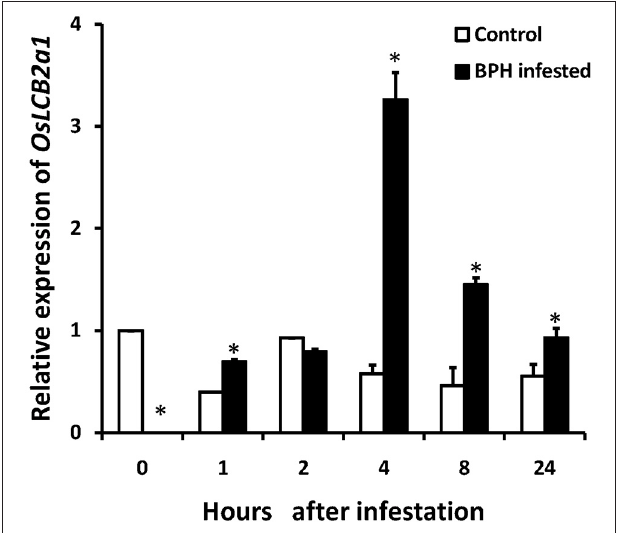
FIGURE 2 | Expression of OsLCB2a1 under BPH attack. Two weeks rice seedlings were infested with 3rd instar BPH nymph (20 nymphs/ seedling). Total RNA was isolated from rice seedlings infested by BPH at 0, 1, 2, 4, 8, 24 h and reversely transcribed into cDNA used as template in quantitative RT-PCR analysis. Values are mean ± SE ( n = 5). The asterisks indicate statistically significant differences between the treatments (One way ANOVA followed by Tukey’s tests, P < 0.05).